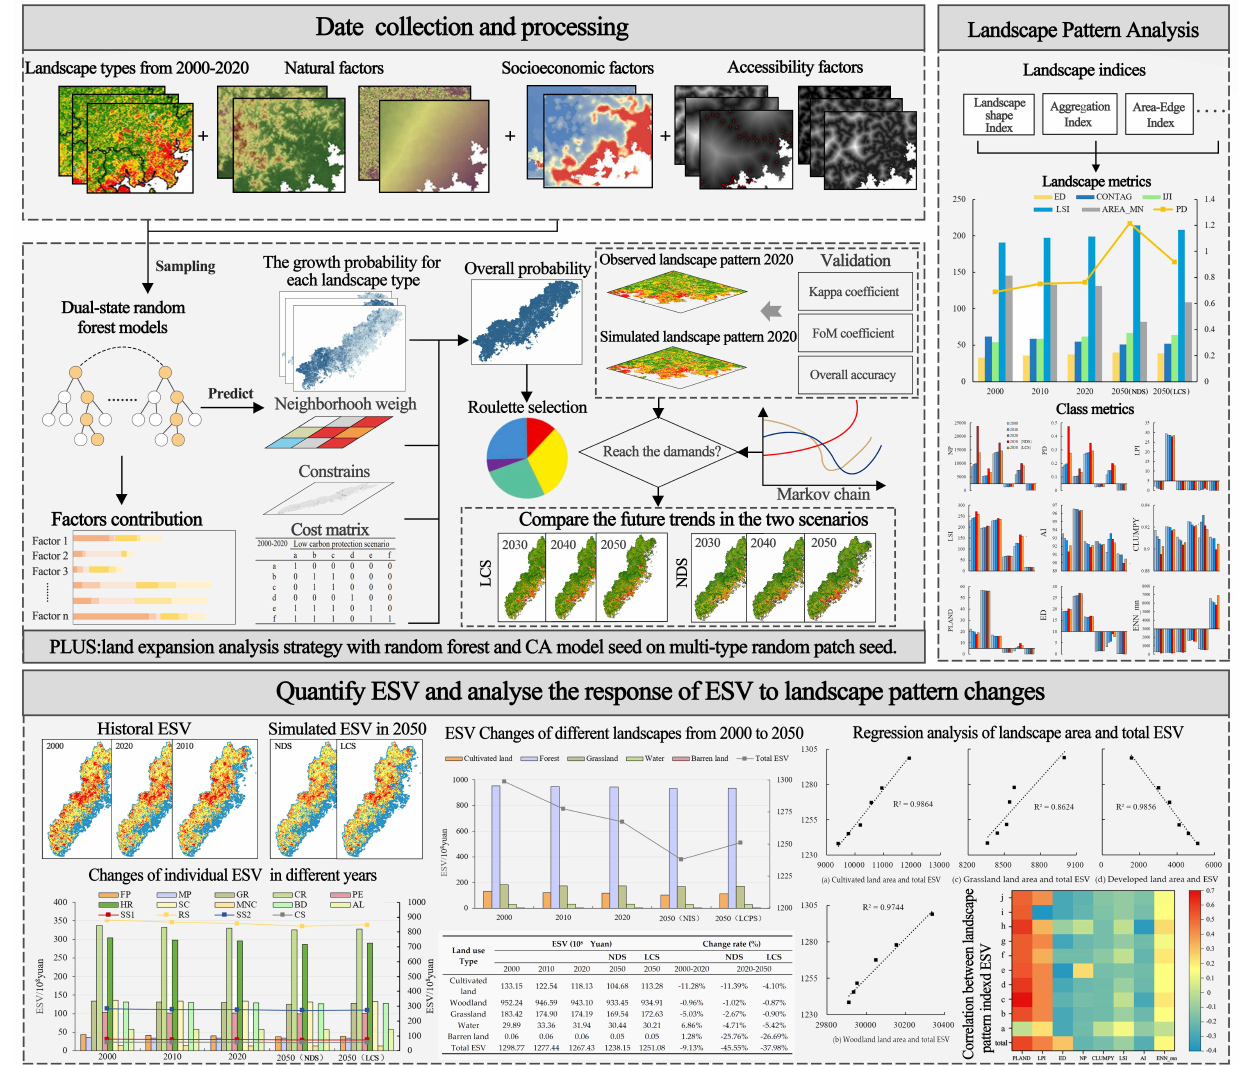
Figure 2. Research framework. PLUS: patch-generating land use simulation; ESV: ecosystem service value; LCS: low-carbon scenario; NDS: natural development scenario.